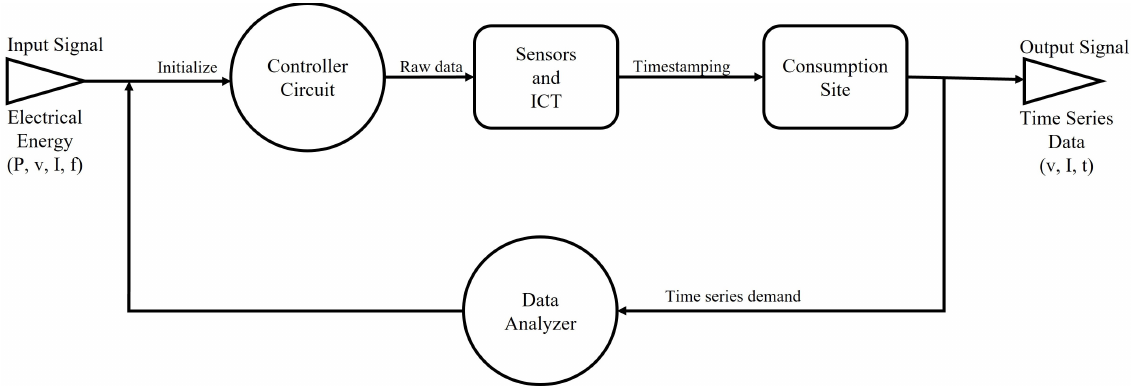
Figure 2. A typical AMI setup for highly granular consumption data at a consumer